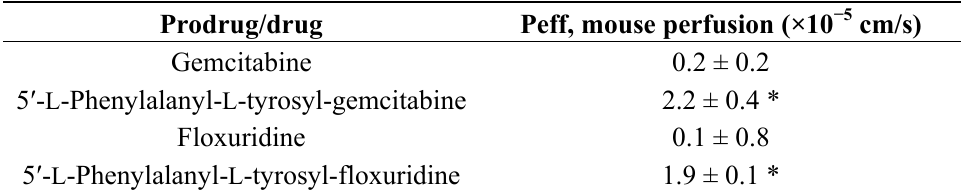
) permeability coefficients of floxuridine, floxuridine prodrug, Table 4. Effective (P eff